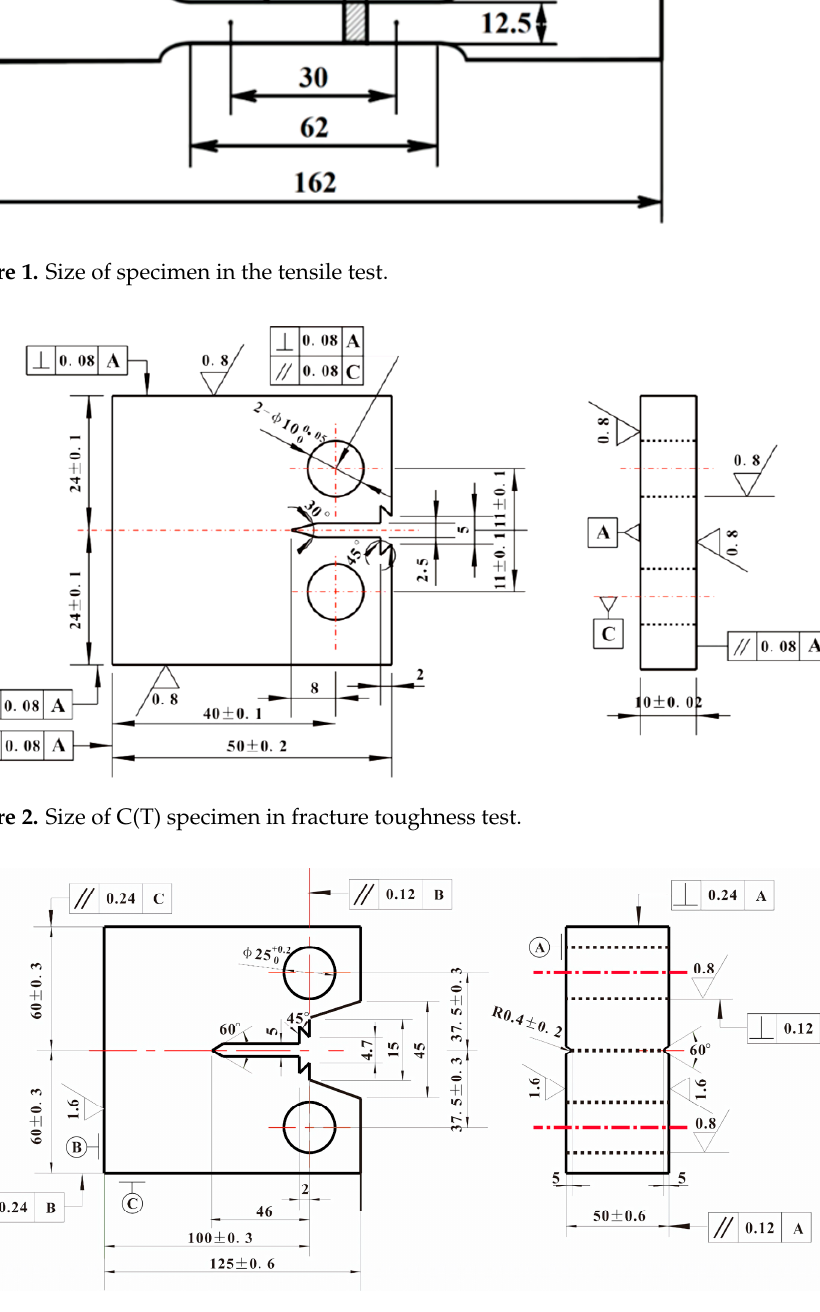
Figure 3. Size of C(T) specimen in fatigue crack growth rate test.